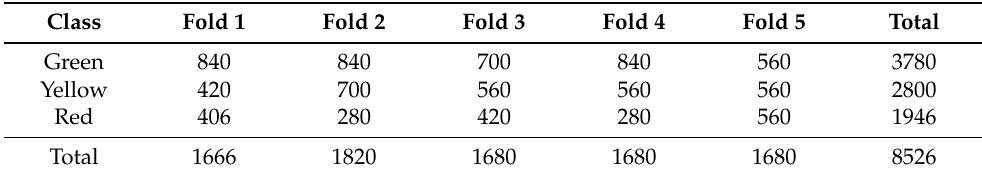
Table 1. Dataset